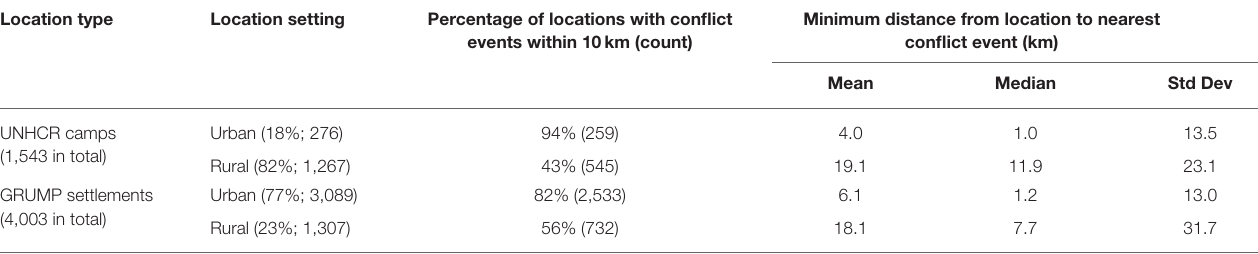
TABLE 2 | Summary of conflict event incidence within 10km of urban and rural UNHCR camp and GRUMP settlement locations and proximity to nearest conflict event. Location